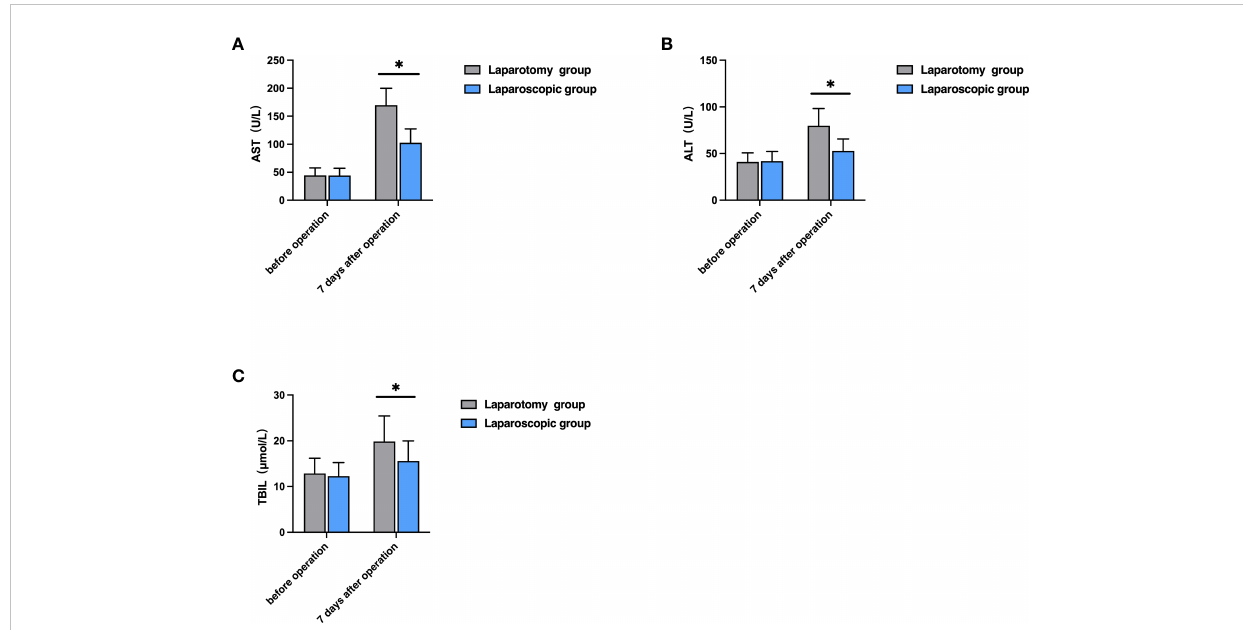
FIGURE 1 Comparison of liver function indexes between the two groups. (A) Comparison of AST level; (B) Comparison of ALT level; (C) Comparison of TBIL level; * P